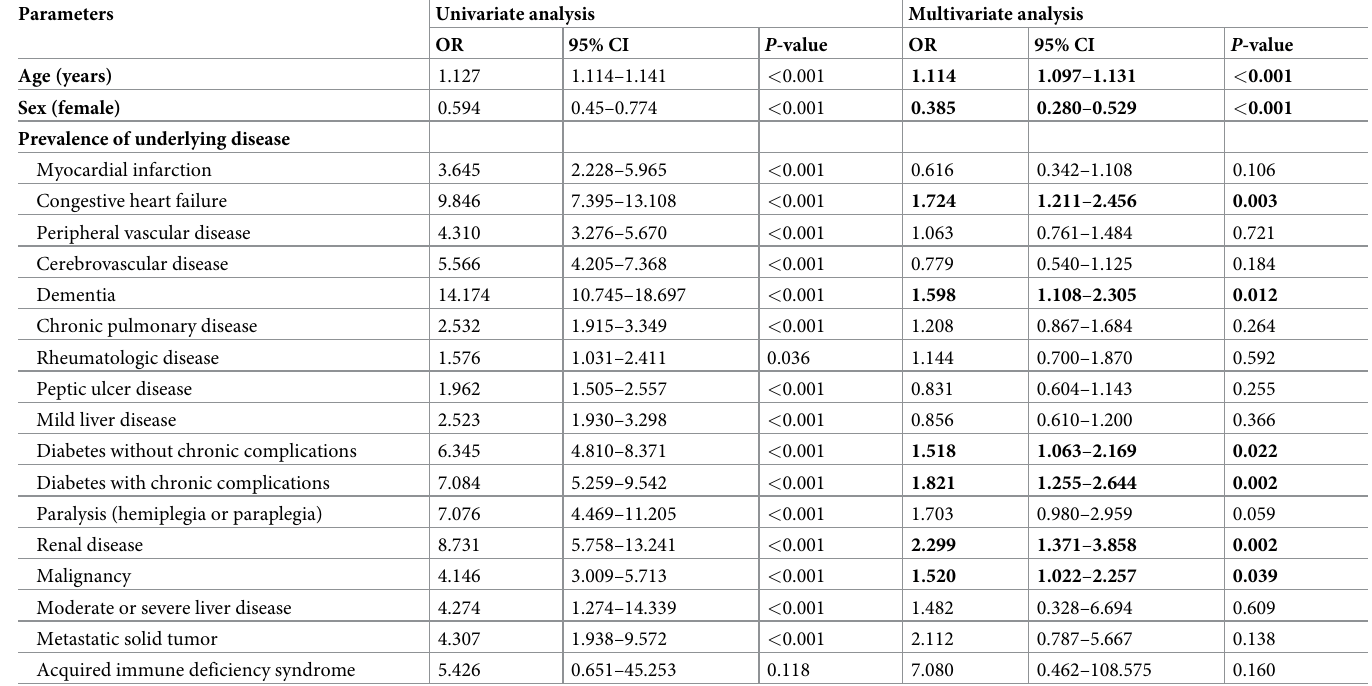
Table 2. Significant factors for